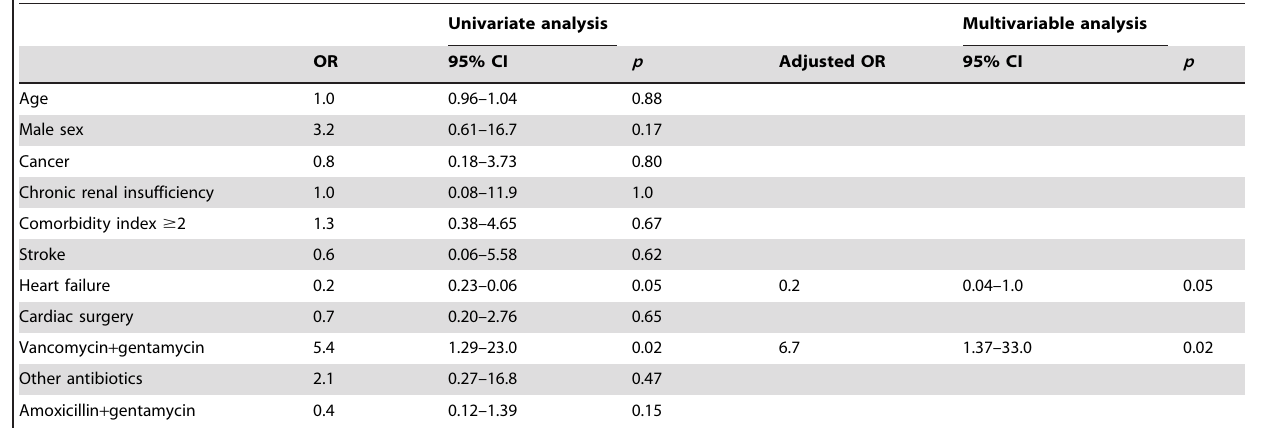
Table 3. Predictors of an increase of BMI $ 10%.